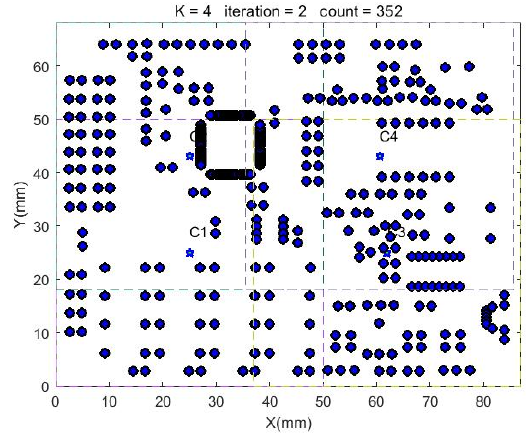
Figure 20. Circuit board processing frame.